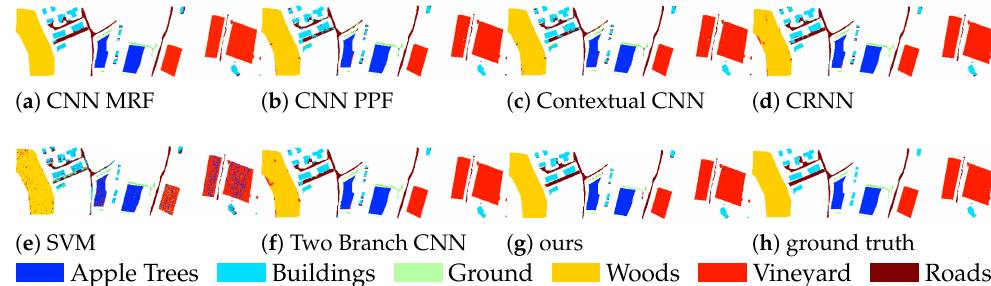
Figure 5. Visualization result of the Trento dataset in certain